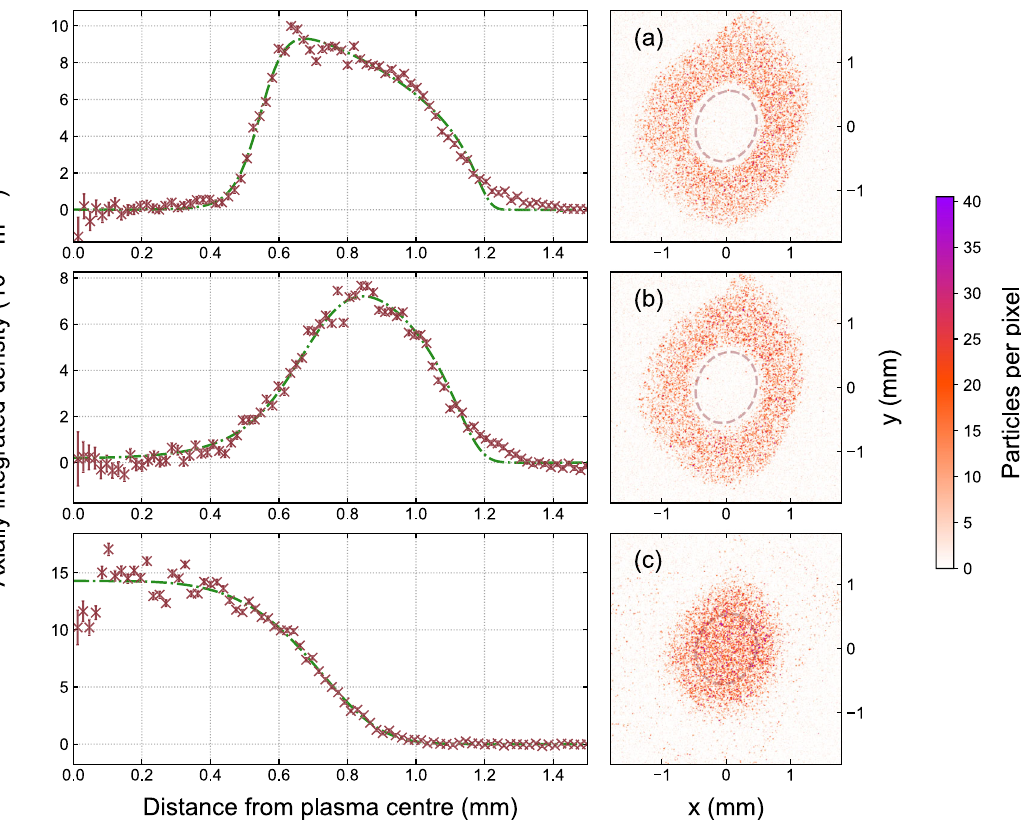
Fig. 4 Be + density pro fi les from originally mixed samples of Be + and e + with 2 × 10 5 Be + and 1.2 × 10 5 e + . The images (right) show Be + ejected to the MCP/Phosphor imaging assembly 5 µ s after the ejection of e + in the opposite direction immediately following the laser-cooling of the Be + . a